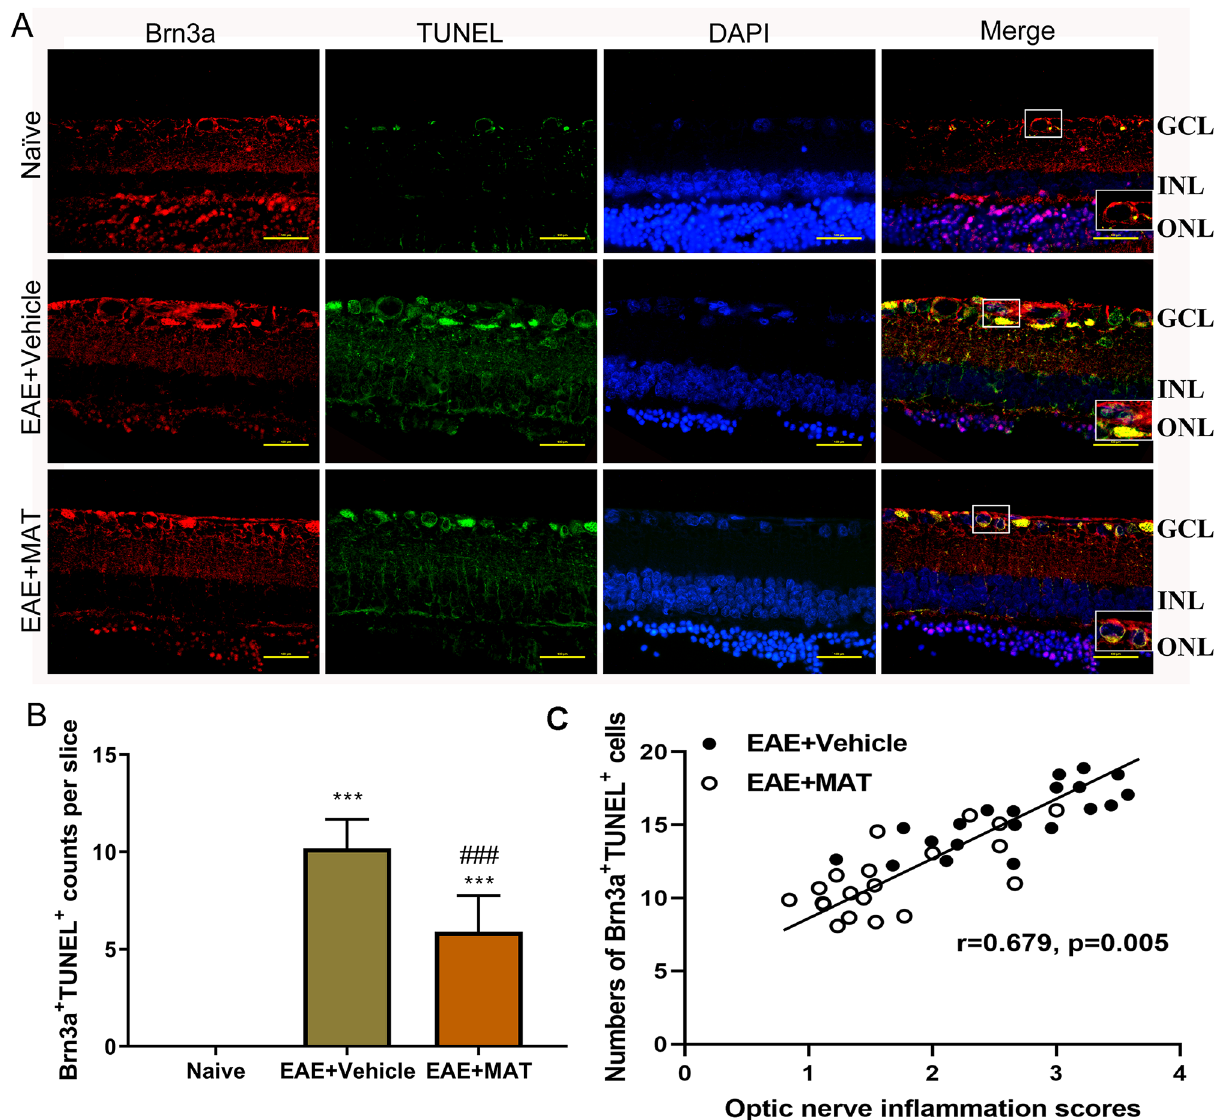
Figure 6. MAT treatment protected RGCs from apoptosis. Neuroprotective effects of MAT were evaluated by counting RGCs immune-labeled with Brn3a antibody and estimating the number of RGC deaths through TUNEL. ( A ) RGCs in the both sides of temporal retina were examined by immunofluorescent double staining by anti-Brn3a (red) and TUNEL (green), and all cells were co-stained with DAPI (blue). ONL, outer nuclear layer; INL: inner nuclear layer; GCL, ganglion cell layer. Scale bars = 100 µm. ( B ) Quantitative analysis for the numbers of apoptotic RGCs (TUNEL + Brn3a + DAPI + ). ( C ) Scatter plots between optic nerve inflammation scores and numbers of Brn3a + TUNEL + cells showing significant positive correlation. Numbers of Brn3a + TUNEL + cells were compared between EAE + Vehicle and EAE + MAT groups using generalized estimating equation (GEE) models with optic nerve inflammation scores as a covariate to adjust for within- subject inter-eye correlations. Subsequently, an adjusted P value was used for multiple comparison according to the Bonferroni correction methods. *** P < 0.001, comparison with the naive group. ### P < 0.001, comparisons between vehicle- and MAT-treated